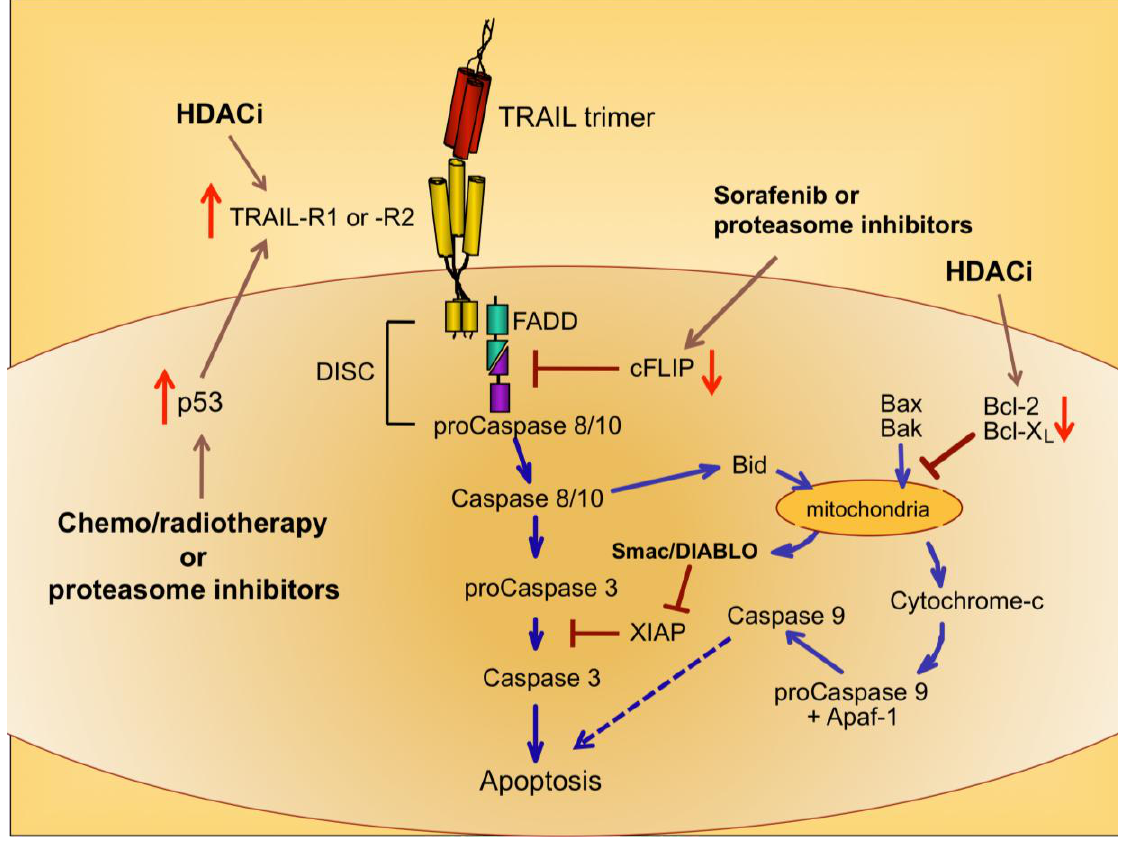
Figure 1. Therapeutic intervention points in the signaling pathways that mediate TRAIL-induced apoptosis. Intracellular pathways that culminate in apoptosis following TRAIL-R1 and -R2 ligation are illustrated. Blue arrows indicate apoptotic signaling pathways. Brown arrows indicate molecular intervention points for therapies that augment TRAIL-induced apoptosis. Red arrows indicate up- or down-regulation of specific molecular